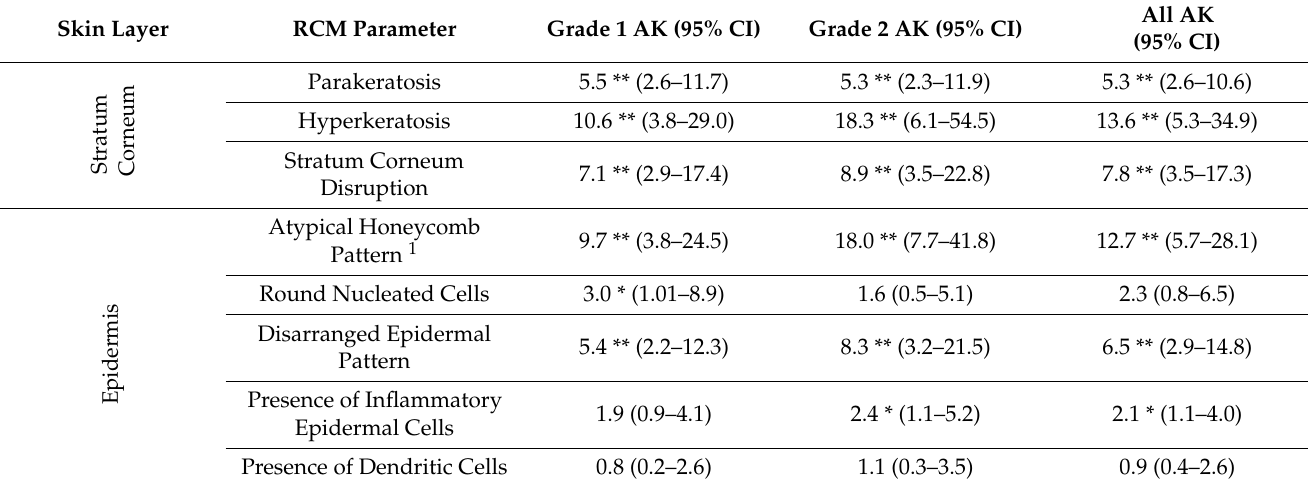
Table 3. Odds ratios comparing RCM parameters in AK to PD skin at